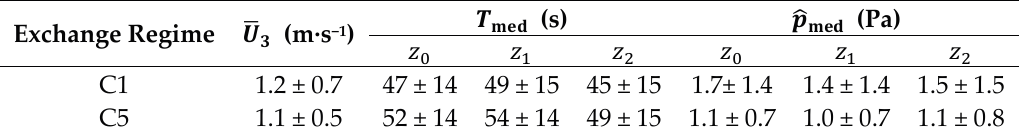
Table 4. Mean values for mean above-canopy wind speed (cid:1847)(cid:3365) (cid:2871) , dominant period in the medium frequency range (cid:1846) (cid:2923)(cid:2915)(cid:2914) and amplitudes in the medium frequency range (cid:1868)̂ (cid:2923)(cid:2915)(cid:2914) under different exchange